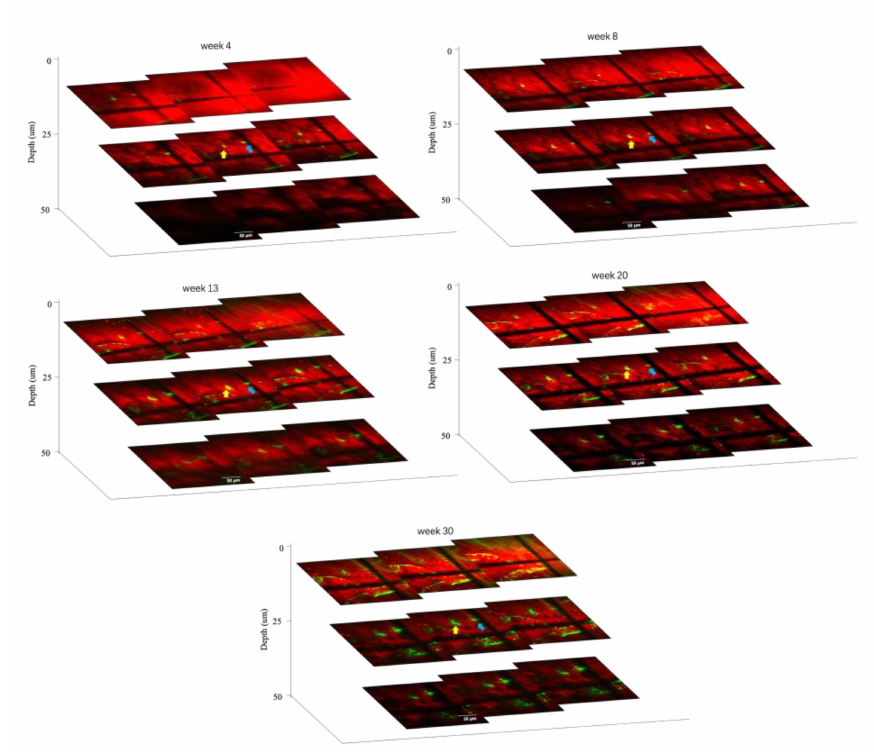
Figure 6. Plaques B (yellow arrow) and C (blue arrow) imaged at different depths over 4-, 8-, 13-, 20-, and 30-week intervals. Scale bar: 50 µ